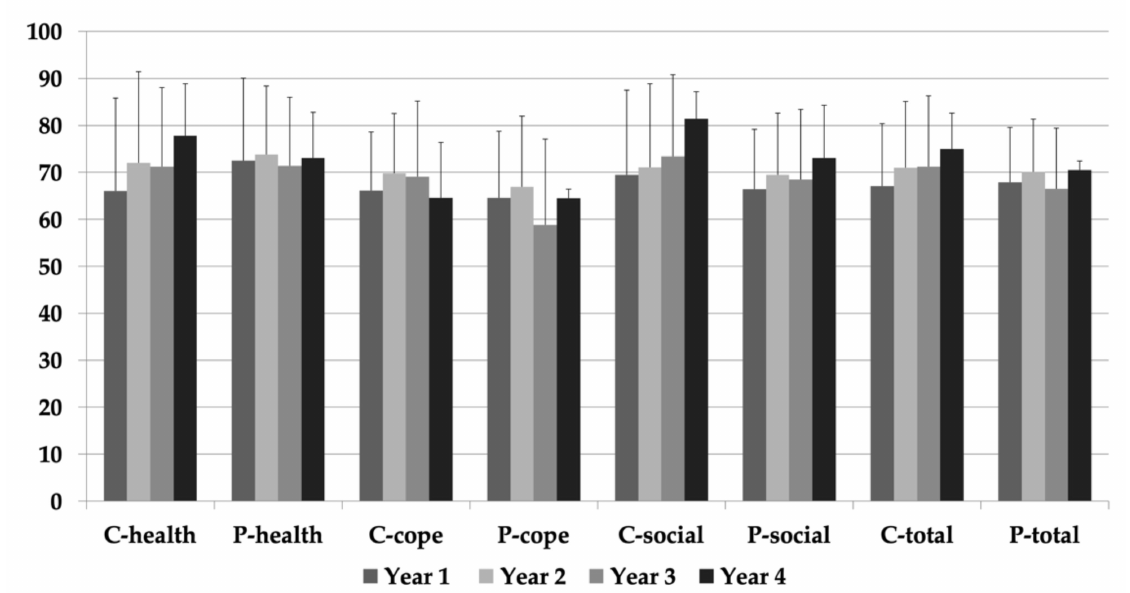
Figure 1. Total and sub-domain scores (Future Health [health], Coping and Adjustment [cope] and Social-Emotional [social]) for both child (C) and parental (P) health-related quality of life (HRQOL) reports over four years. All values expressed as mean ± standard error. No statistical significance